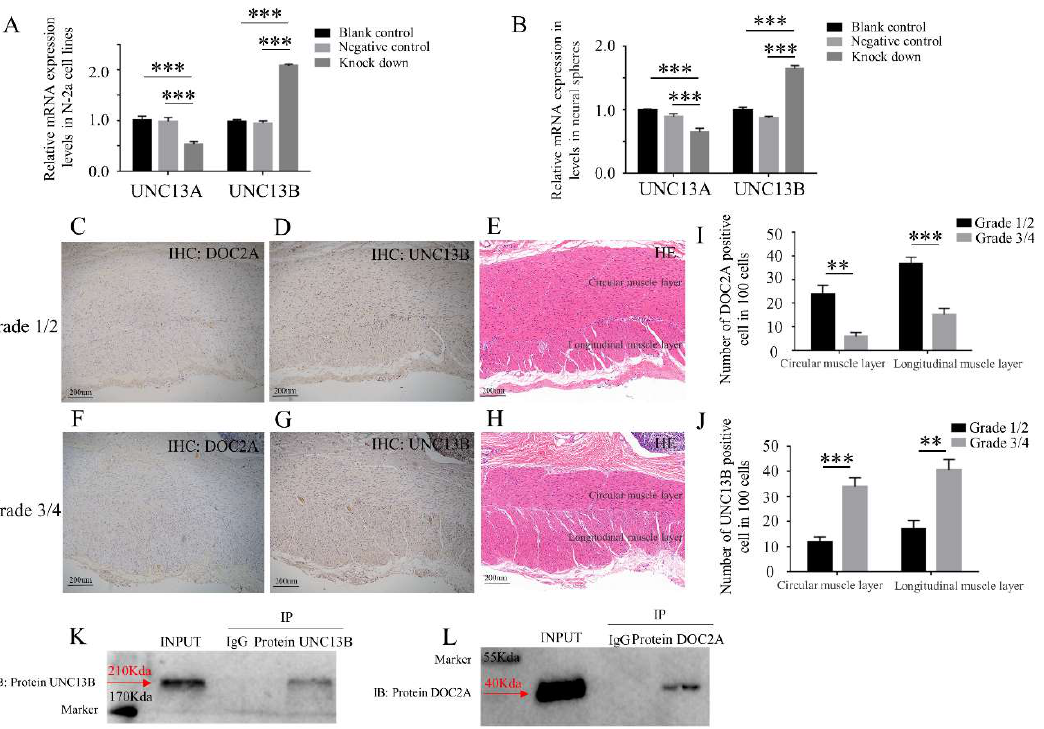
Figure 7. Expression relationship between DOC2A and UNC13B. ( A , B ) Change in UNC13B after DOC2A being knocked down in N-2a cell lines and neural spheres. ( C – J ) Expression levels (IHC) of DOC2A and UNC13B in different grades of HSCR patient colons. **, p < 0.01; ***, p < 0.001, one-way ANOVA with Bonferroni post hoc, n = 3. ( K , L ), protein interaction (CO-IP) between DOC2A and UNC13B. Abbreviations: UNC13B, unc-13 homolog B; IHC, immunohistochemistry; HE, hematoxylin-eosin staining.